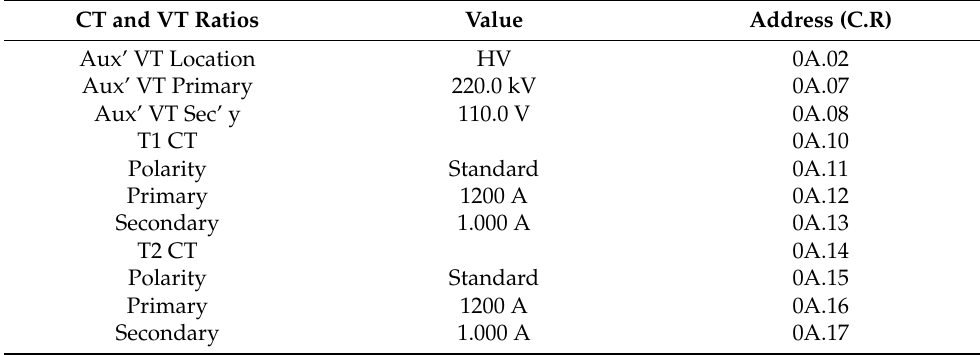
Table 2. CT data implementation in differential relay on 220 kV GS KSK 160 MVA transformer